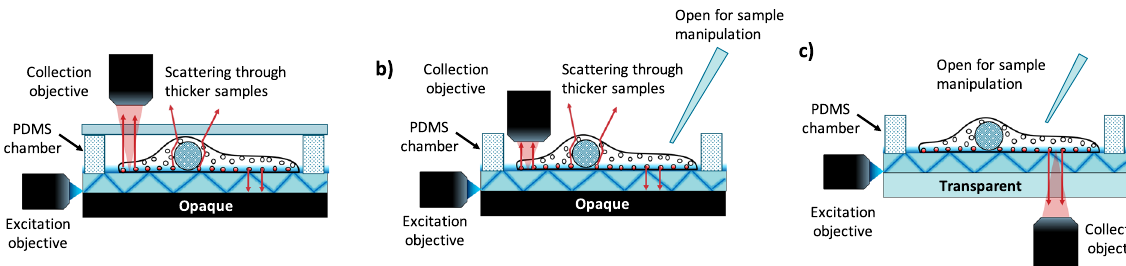
Fig. 1 Schematic illustrating the differences between light paths in opaque versus transparent c-TIRF. Light is coupled into the waveguide from an excitation objective lens, shown on the left side of the chip. The coupled light is re fl ected between the interfaces with the substrate a opaque with water immersion objective lens b opaque with water dipping objective lens and c transparent and the sample, keeping the light totally within the waveguide and generating an evanescent fi eld to illuminate the bottom layer of the sample (shown as a blue line). a , b Using a waveguide on an opaque substrate, emitted fl uorescence (red arrows) must pass through the bulk of the sample, potentially experiencing scattering or other distortions, before it can be collected by an objective located above the sample in an upright con fi guration. With a transparent substrate, emitted light can be collected by either an upright con fi guration as shown in ( a , b ) or by an inverted microscope as shown in ( c ). With the inverted setup, the light only needs to pass through the relatively homogeneous chip rather than a distorting sample. Additionally, in ( b , c ) the area above the sample can be left open to allow for the addition of reagents or for micromanipulation during imaging. The fi gure is not drawn to scale for the purpose